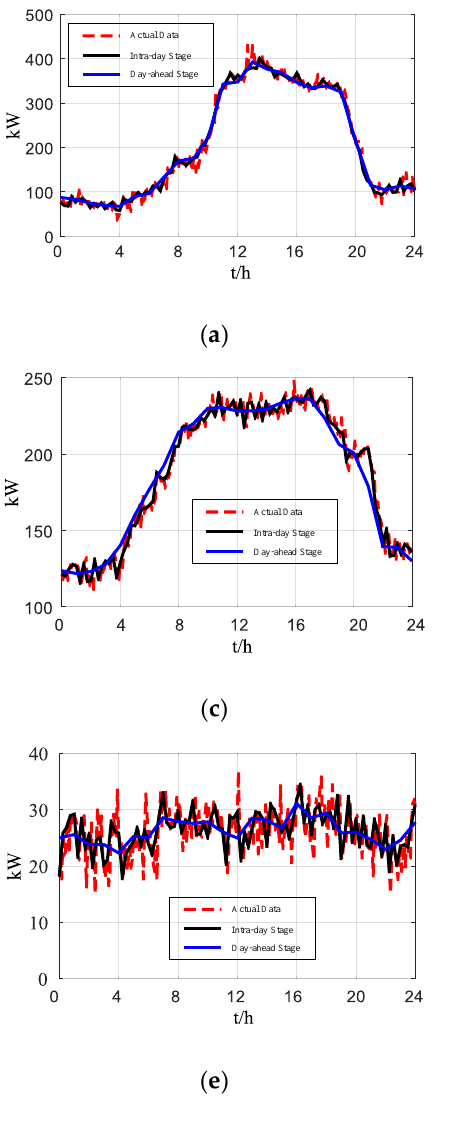
Figure 5. Data of the system. ( a ) System cold load. ( b ) System thermal load. ( c ) System electrical output. ( d ) System photovoltaic output. ( e ) System wind turbine output. ( f ) System time-of-use electricity price. Table 1. Basic purchase and sale prices for the microgrid and large grid.